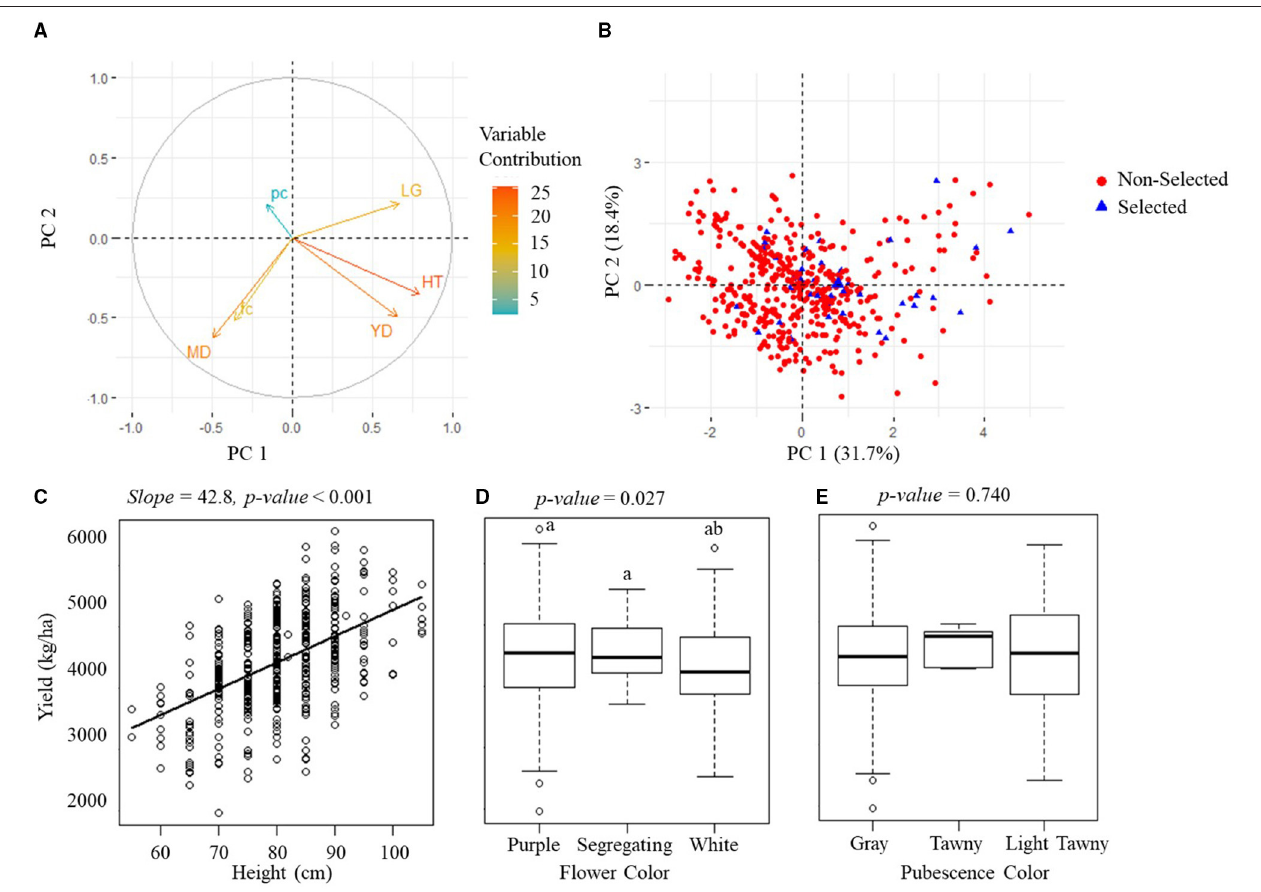
FIGURE 7 | Manually measured agronomic traits in AYT. (A) The visualization plots of the variables’ contributions and directions in the plane of the first two PCs. YD, yield; HT, plant height; MD, maturity date; LG, lodging; fc, flower color; pc, pubescence color. (B) The projection of sample variables on the first two PCs. (C) The scatterplot of yield vs. plant height. (D,E) are boxplots of the yield of three groups of flower color and three groups of pubescence color. The p-value above (C–E) indicates the significance level of